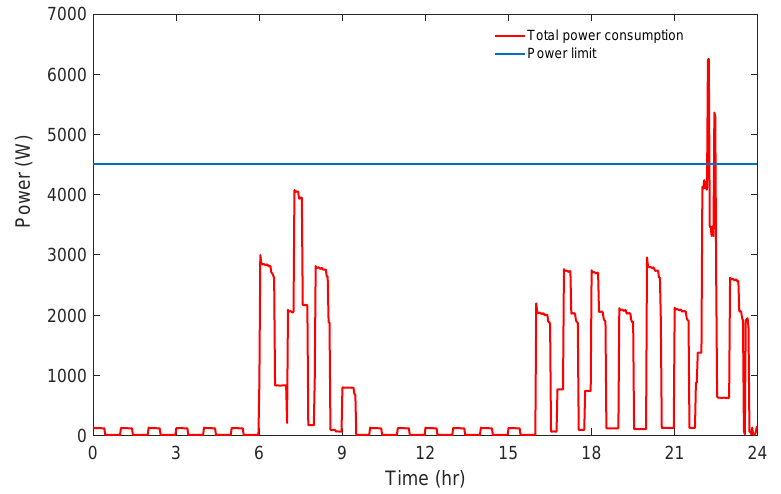
Figure 7. Power consumption graph of the minimum cost solution for Scenario